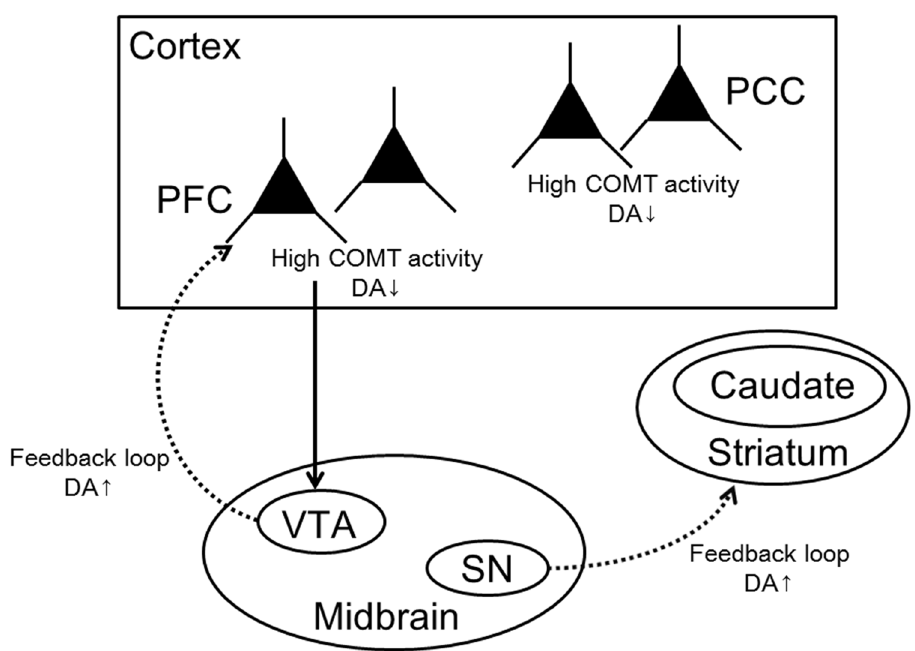
Fig 3. Circuitry elements in the effect of the Val/Val genotype on dopamine levels. Relative to the Val/ Met genotype, the COMT enzyme from the Val/Val genotype leads to reduced dopamine levels in the cortex, including the PFC and PCC. Although projections from the PFC to the midbrain directly contact dopaminergic cell groups in the ventral tegmental area that project back to the PFC to generate low dopamine levels, they indirectly elevate the dopamine levels via dopaminergic cell groups in the substantia nigra that project to the striatum [29, 30]. In the striatum, the direct influence of COMT is weak because the dopamine level is predominantly regulated by dopamine reuptake through presynaptic transporters [31, 32]. Therefore, Val/Val individuals have lower dopamine levels in the PCC and higher dopamine levels in the caudate than those in Val/Met individuals. DA = dopamine, PFC = prefrontal cortex, PCC = posterior cingulate cortex, VTA = ventral tegmental area, and SN = substantia